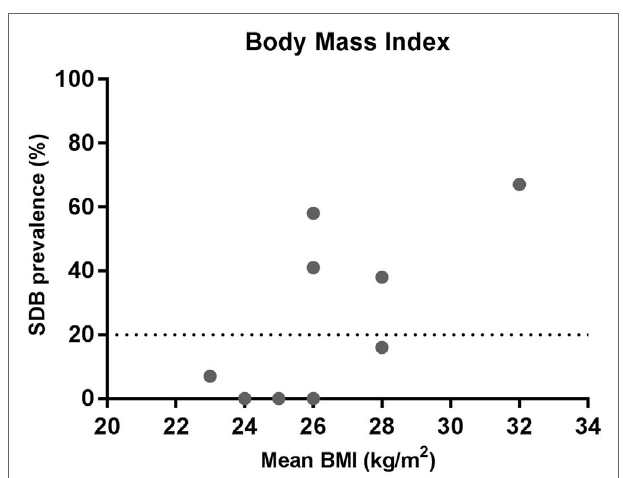
FigURe 2 | Relationship between sleep-disordered breathing (SDB) prevalence and mean body mass index (BMI). The data show the prevalence of SDB and mean BMI from the studies listed in Table 1 where BMI was reported.